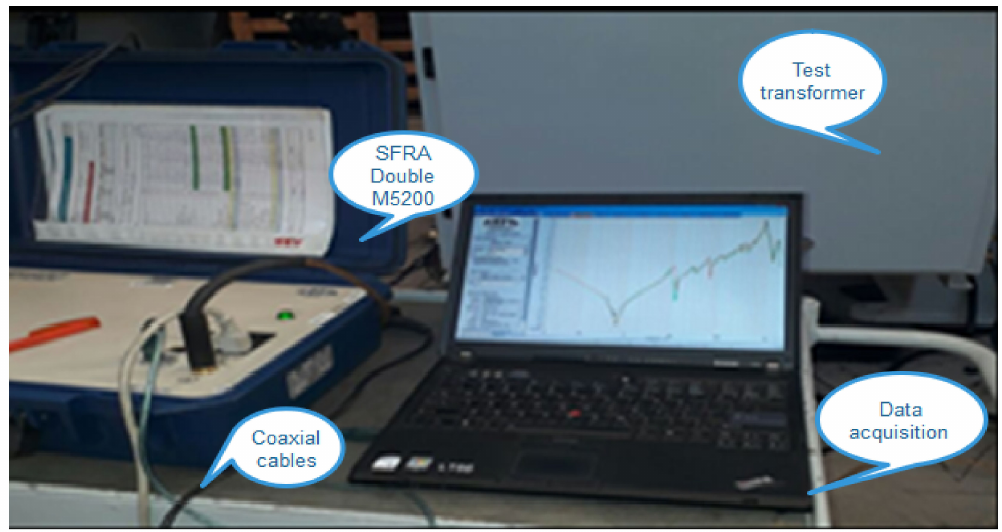
Figure 6. M5400 FRA Measurement